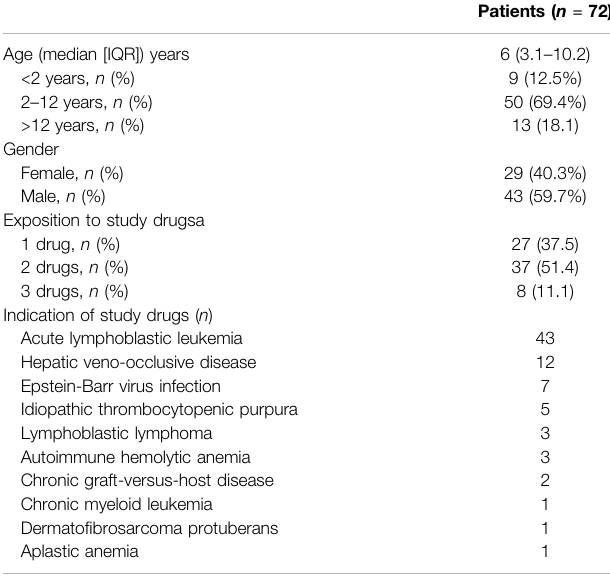
TABLE 1 | Baseline characteristics of the cohort of patients exposed to study drugs.